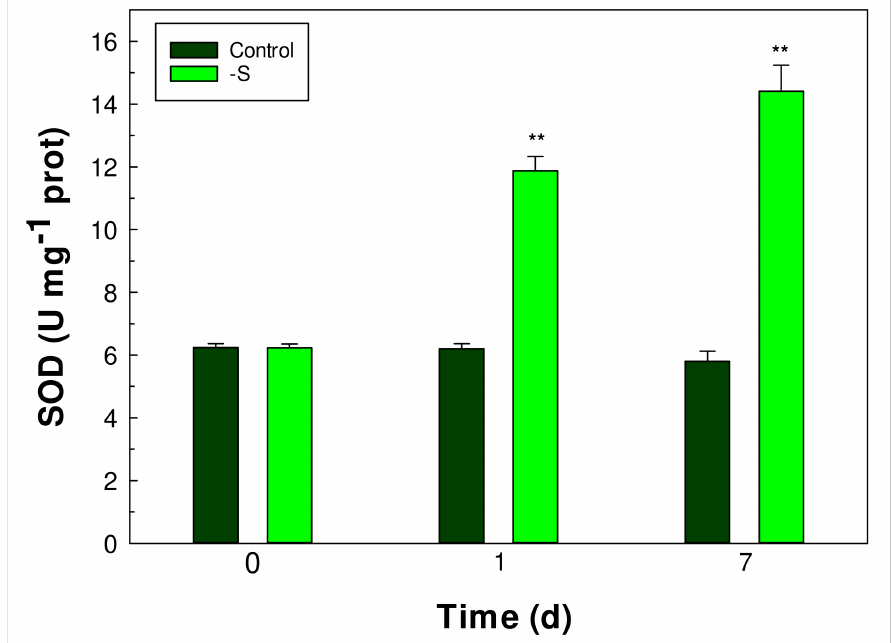
Figure 8. SOD activity in control and S starved (-S) cells of Galdieria sulphuraria . Error bars represent SD ( n = 3). Significant differences between control and -S were determined by Tukey HSD test and indicated by asterisks (** p <